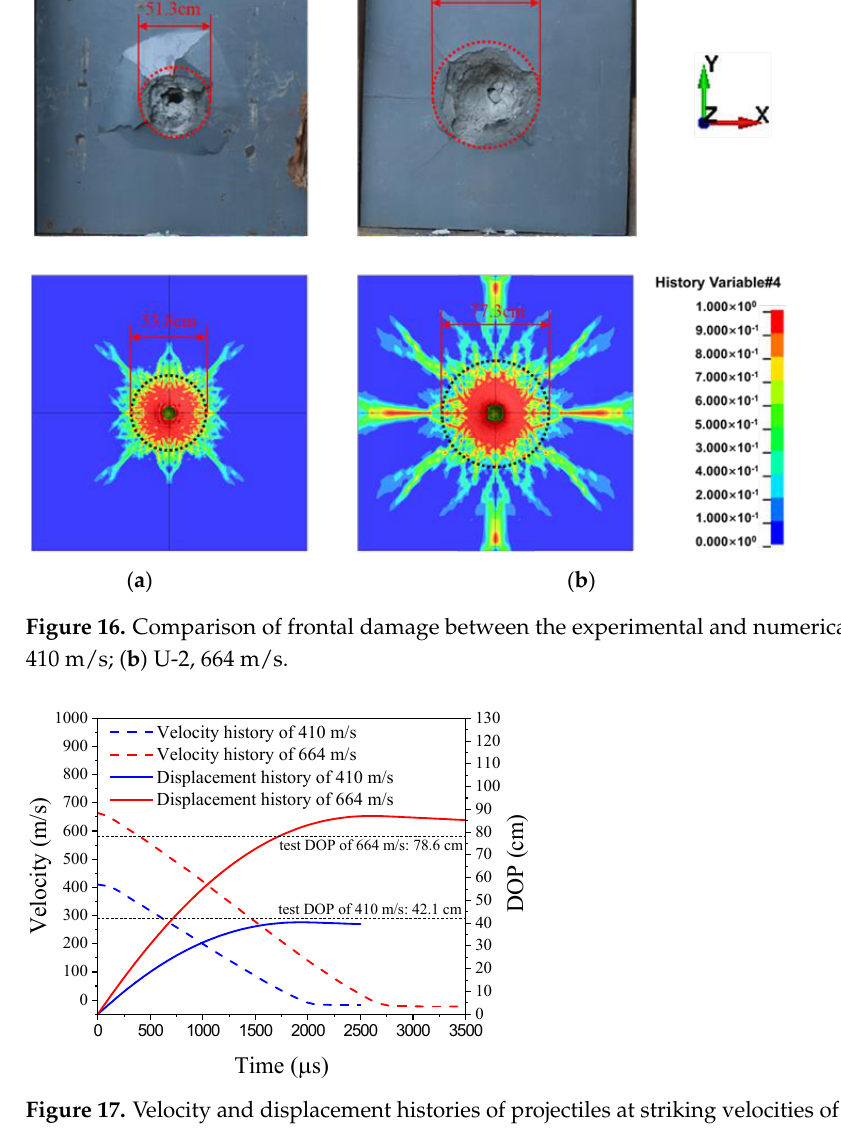
Figure 16. Comparison of frontal damage between the experimental and numerical results; ( a ) U-1, 410 m/s; ( b ) U-2, 664 m/s.